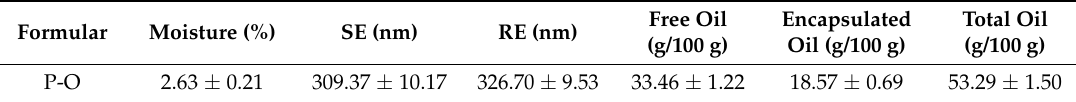
Table 5. The effect of the optimal spray drying condition on moisture amount, particle size and oil amount (free oil, encapsulated oil and total oil) of spray-dried omega-3 powder using γ -CD and hydrogenated lecithin (n =